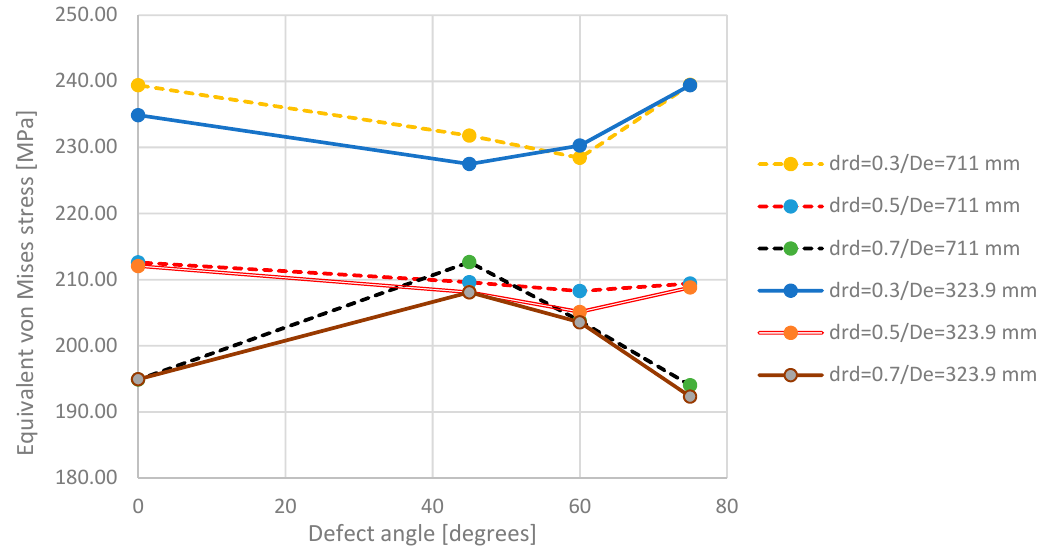
Figure 12. Equivalent von Mises stress maxima for 711 mm and 323.9 mm steel pipes, type III composite and different relative defect depths.